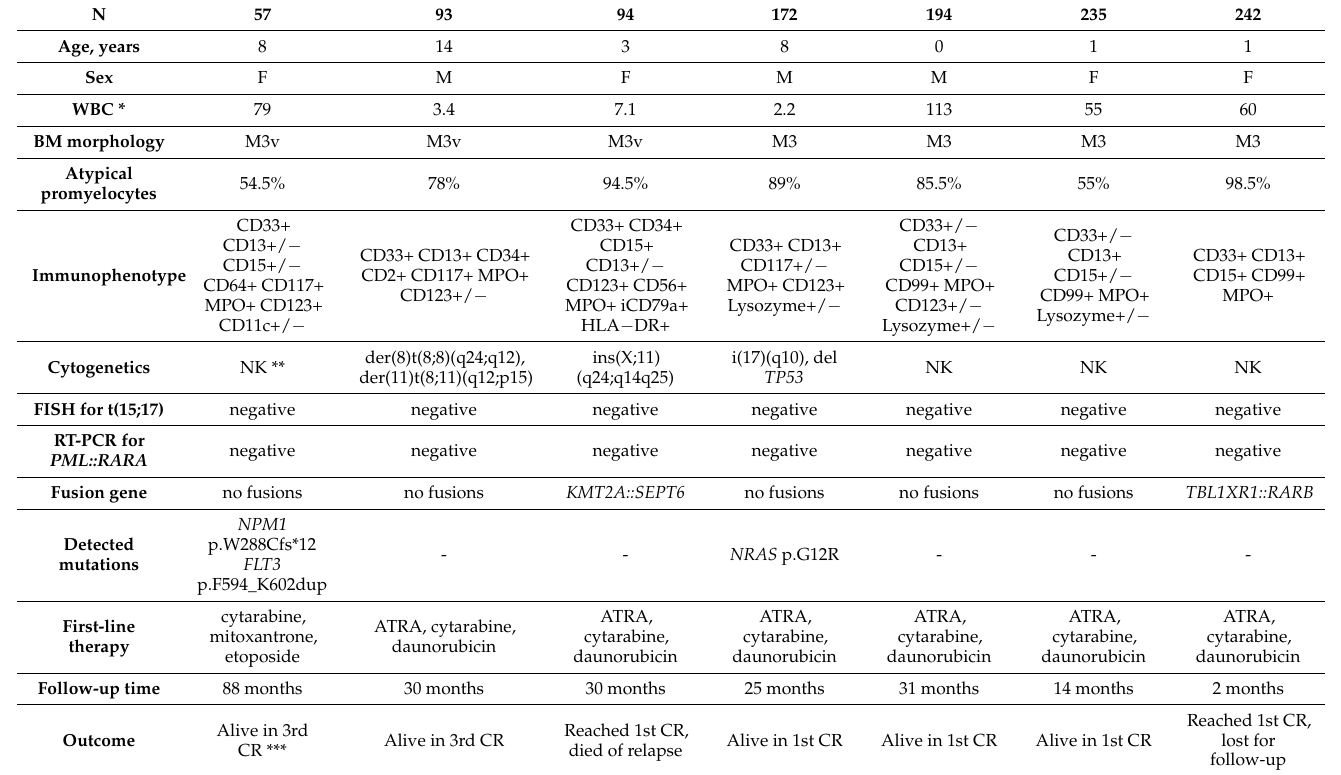
Table 1. Clinical and molecular-genetical characteristics of pediatric RARA -negative patients having AML with atypical promyelocytes accumulation.